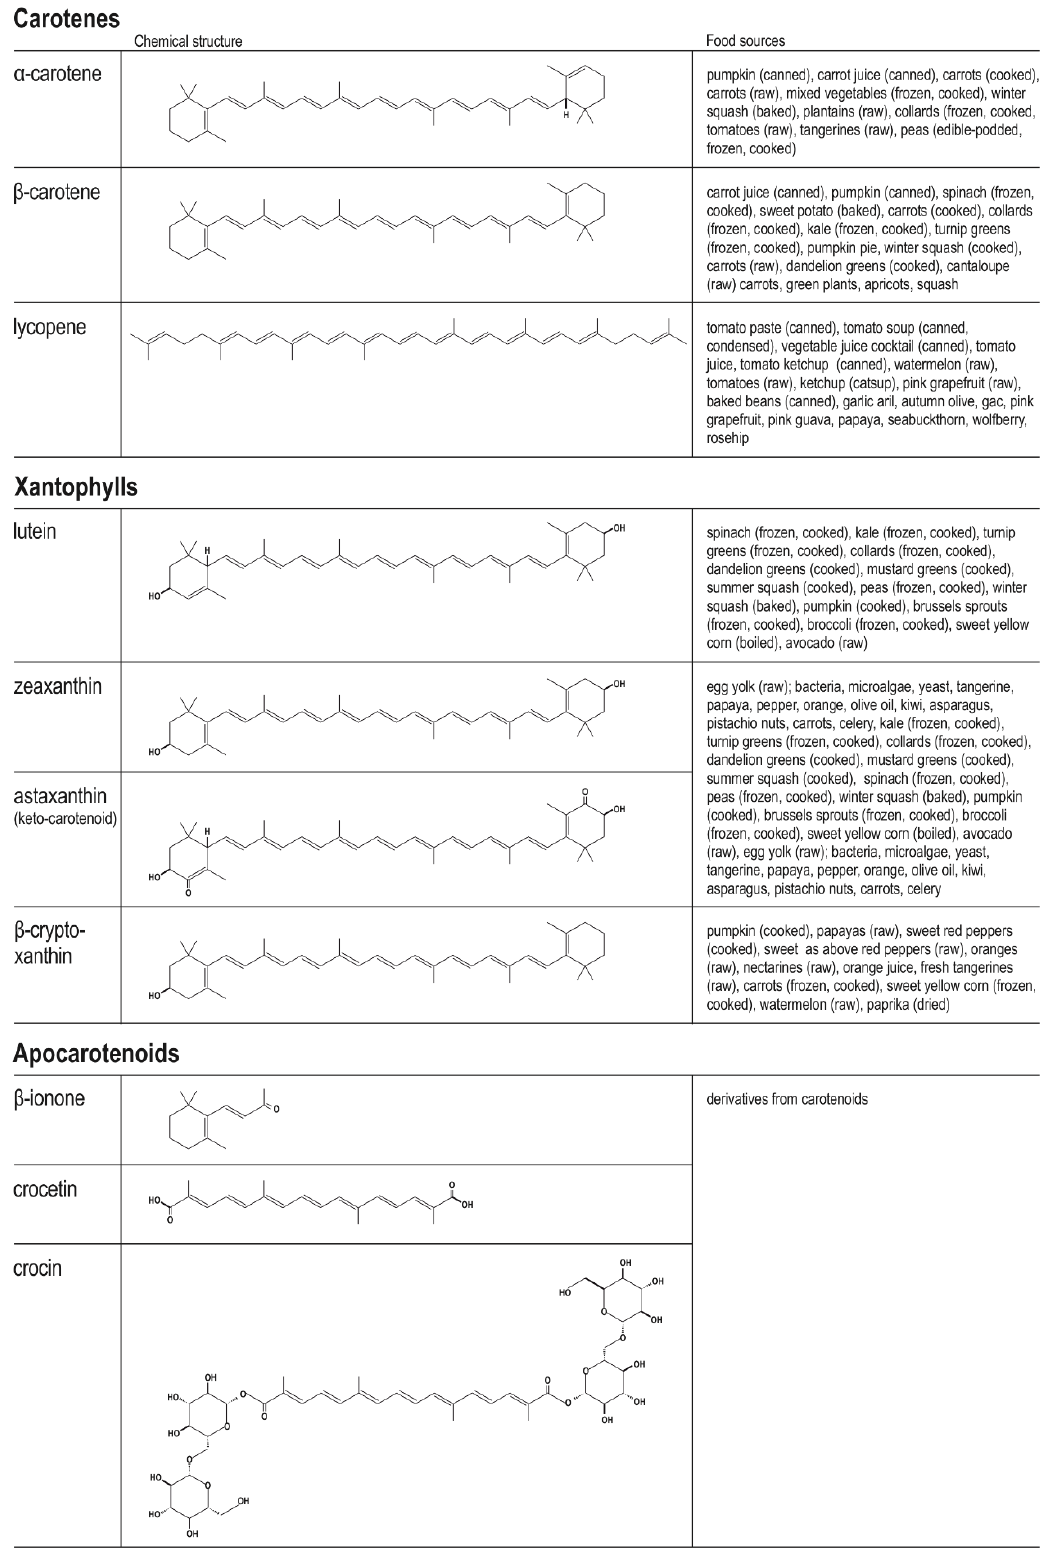
Figure 2. Examples of the major dietary carotenoids, their chemical structure, and food sources. Interestingly, research indicates that increasing vegetable and fruit intake, these being rich sources of CTDs, can diminish cases of either oral leukoplakia HNC or weaken